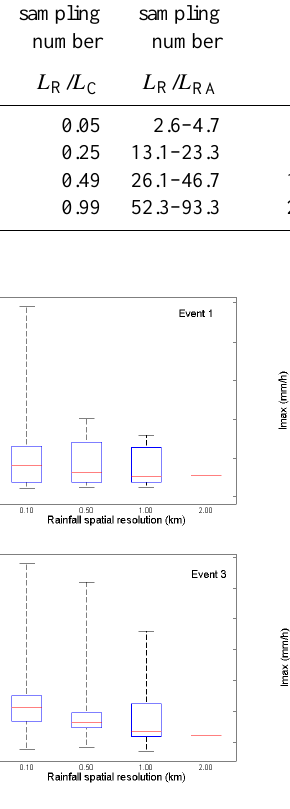
Figure 7. Boxplots of maximum rainfall intensity (mmh − 1 ) among all pixels covering the catchment area, for the four spatial resolu- tions (the 2000m shows a unique value corresponding to rainfall uniformly distributed over the catchment), for the four events anal-